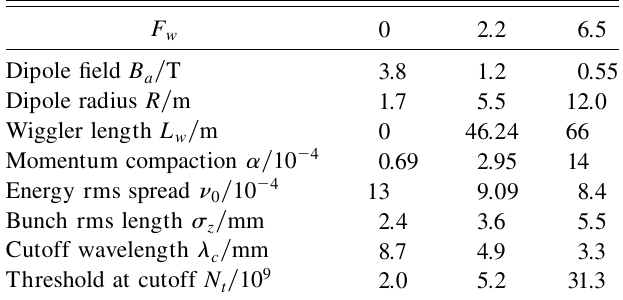
TABLE II. Parameters and results for the NLC main damp- (cid:4) 0 , 2.2, and 6.5. ing ring when F w